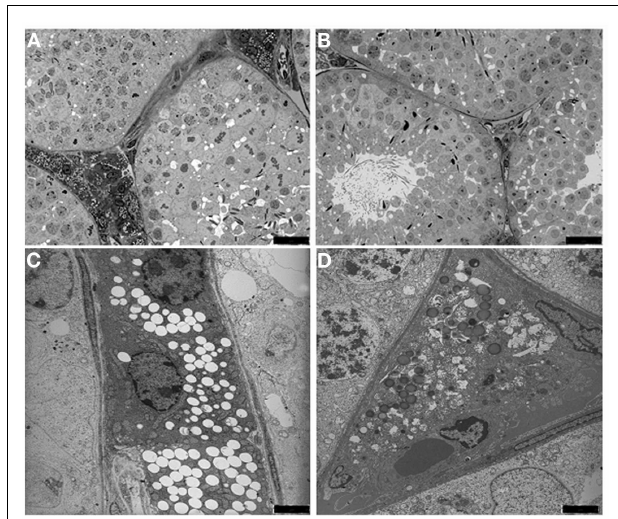
FIGURE 2 | Light microscopy (A,B) and transmission electron micrograph (C,D) of the interstitium from wild type (A,C) andTwitcher (B,D) testes . In the peritubular interstitium of wild type mice numerous Leydig cells are presents and filled with lipids droplets and lysosomes, whereas inTwitcher mice the interstitial cells are strongly reduced in number and appear partially degenerated [ (A,B) : bars = 25 µ m; (C,D) : bars = 2 µ